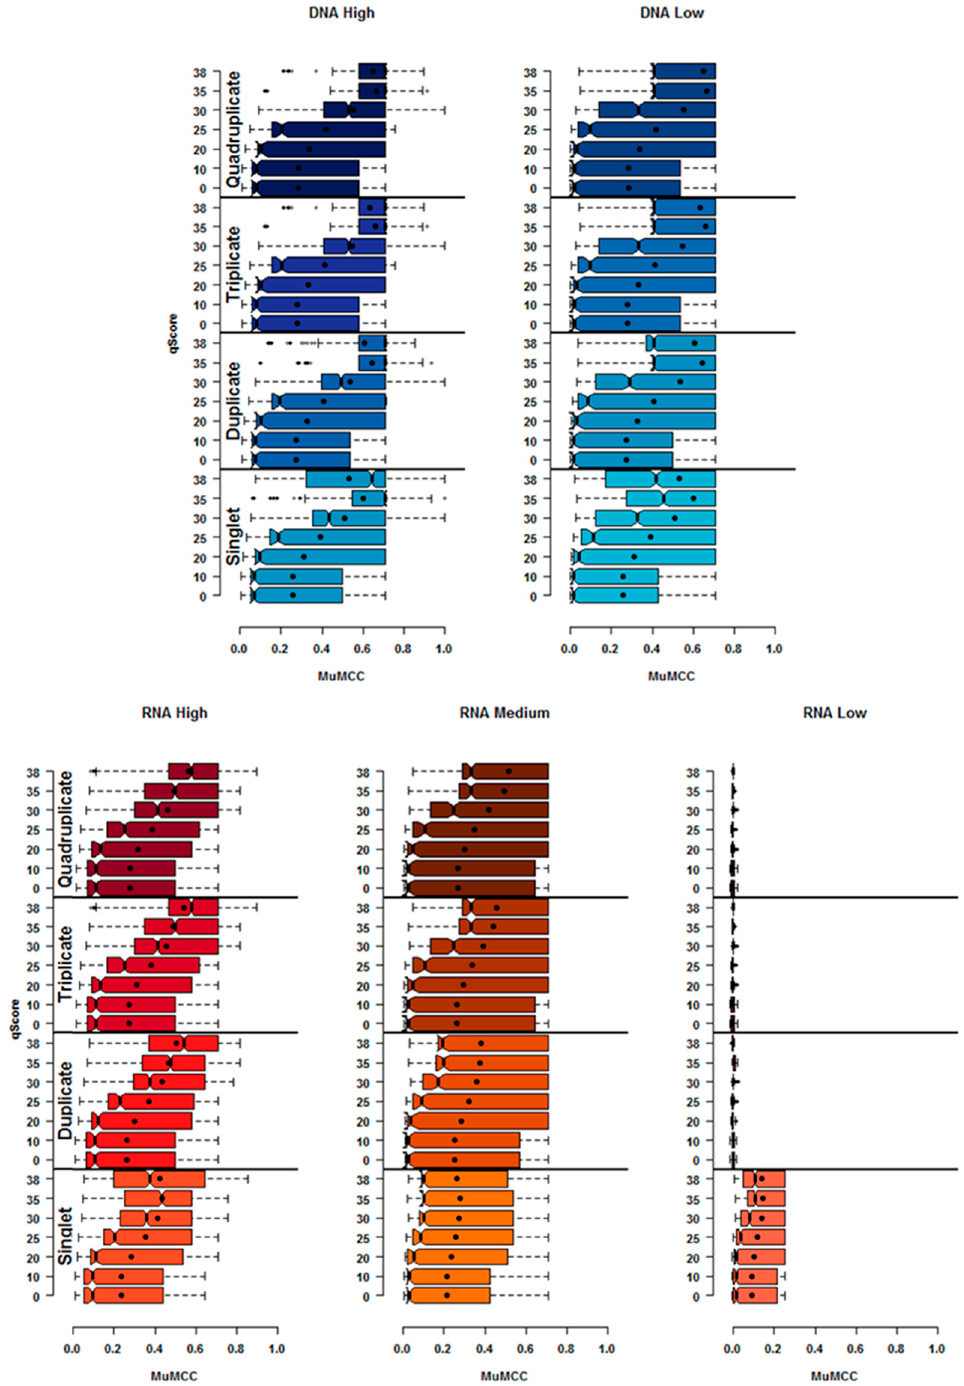
Figure 3. The effect of qScore and number of replicates on SNV calling accuracy. The range of MuMCC scores of each population input for each qScore parameter and technical replicate combinations tested. Singlet, duplicate, triplicate and quadruplicate technical replicates are represented by a different shade of colour. The solid black dot within each boxplot indicates the mean of the MuMCC distribution. Minimum and maximum whiskers on each bar plot indicate the highest and lowest MuMCC scores.